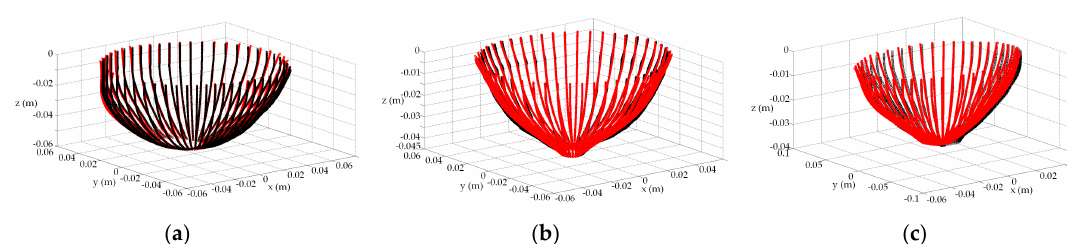
Figure 12. Comparison between the goodness of fit of profile as the azimuth angle varies between profile estimated with electromagnetic (black) and laser (blue) surface samples for models A ( a ), B ( b ), and C ( c ). Figure 13. Contours of surface model are uniformly sampled to form a cloud of points (red dots andblack dots) corresponding to the estimated surface from the electromagnetic and laser data, respectively. Surface estimates of models ( a ) A, ( b ) B, and ( c ) C.